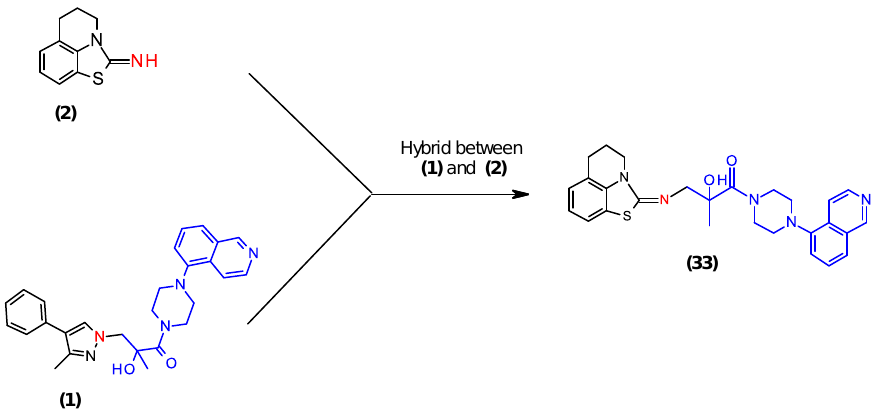
Scheme 5. Rationale design of the bisubstrate inhibitor ( 33